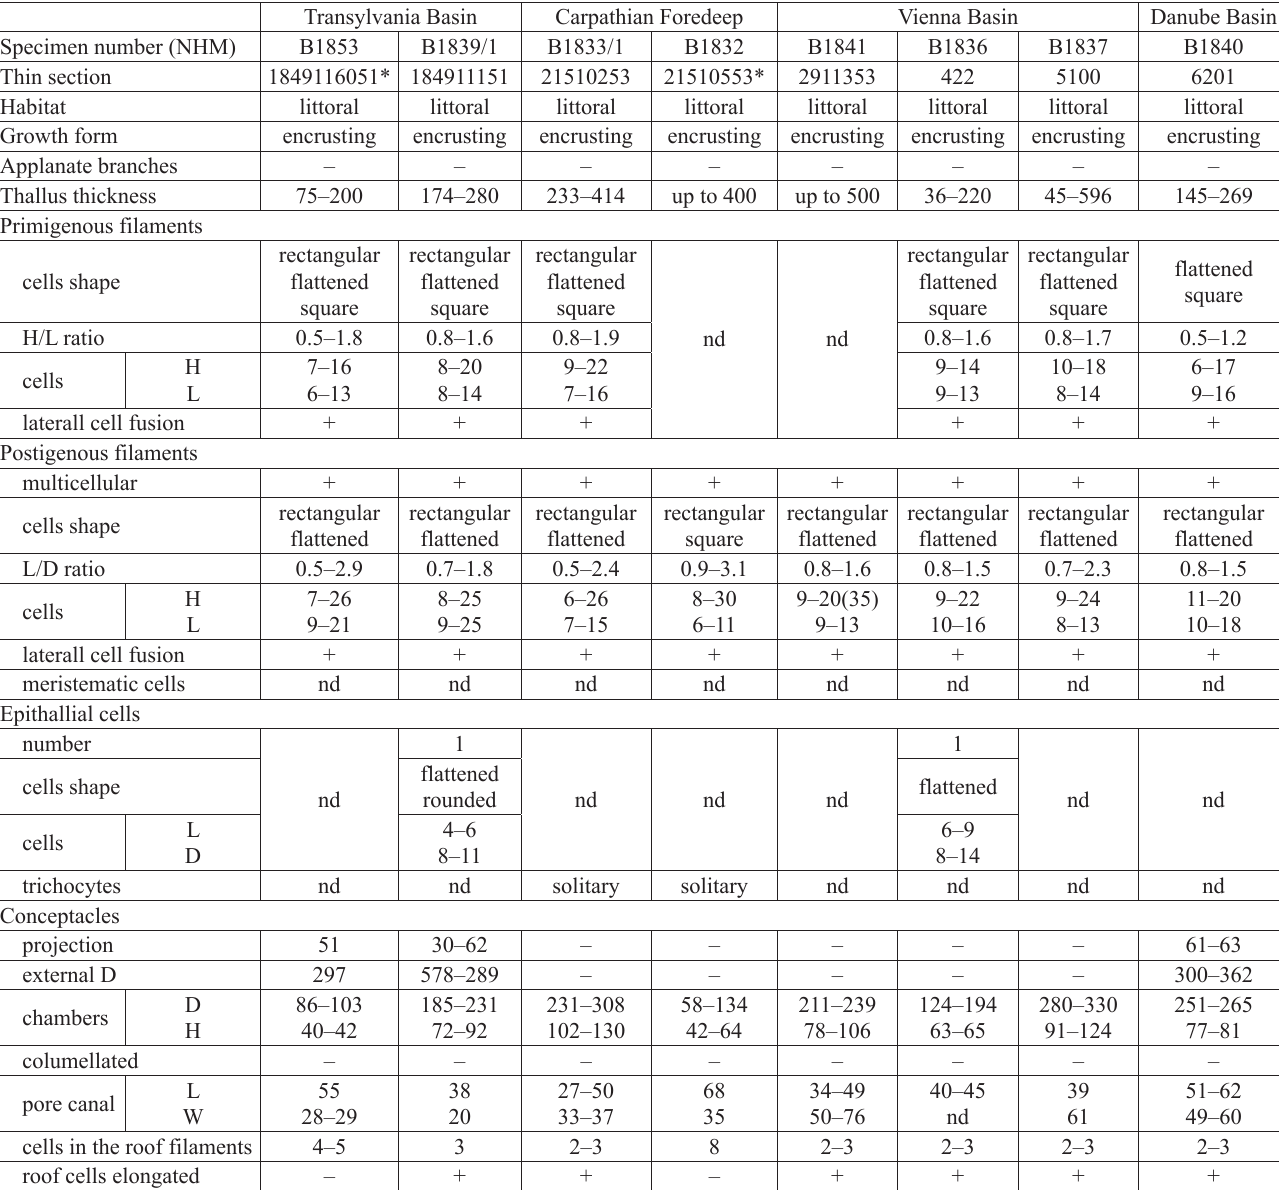
Table 4. Comparative table of selected Hydrolithon corculumis (Maslov, 1962) Braga, Bassi, Zakrevskaya, and Petrovna-Radionova, 2005 specimens. * marks gametangial or carpogonial-carposporangial plants. Abbreviations: D, diameter; H, height; L, length; W, wide; nd, no data; “+” presence and “–” absence of character. All measurements in μ